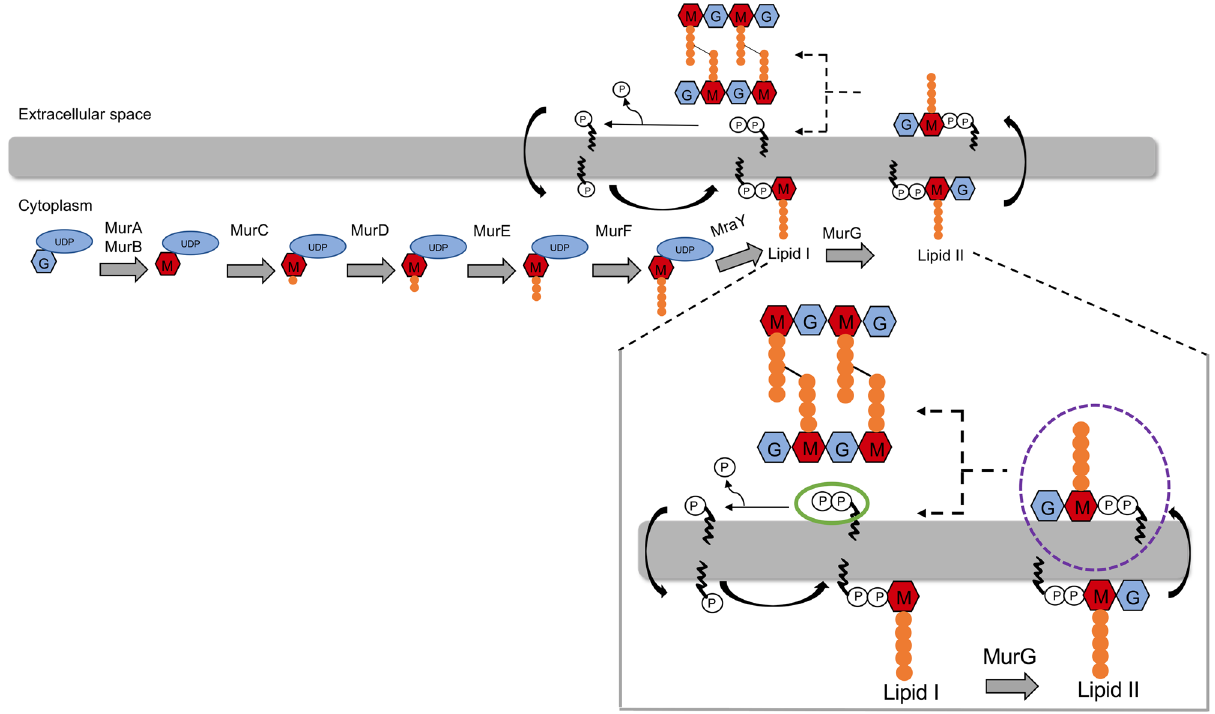
Figure 1. Schematic view of peptidoglycan synthesis. Synthesis of lipid II in the cytoplasm and its incorporation into the peptidoglycan. Phosphates are marked with a P, undecaprenyl as a black curved line, uridine phosphate (UDP) in light blue, GlcNAc in blue, MurNAc in red and amino acids of the pentapeptide in orange. Enlarged step of peptidoglycan synthesis showing targets of bacitracin, which is undecaprenyl pyrophosphate (green circle), and targets of many antimicrobial peptides, such as nisin, gallidermin, lysobactin, and ramoplanin: lipid II (violet, dotted circle). GlcNAc N -acetylglucosamine; MurNAc N -acetylmuramic acid. The figure was created using Microsoft Powerpoint Version